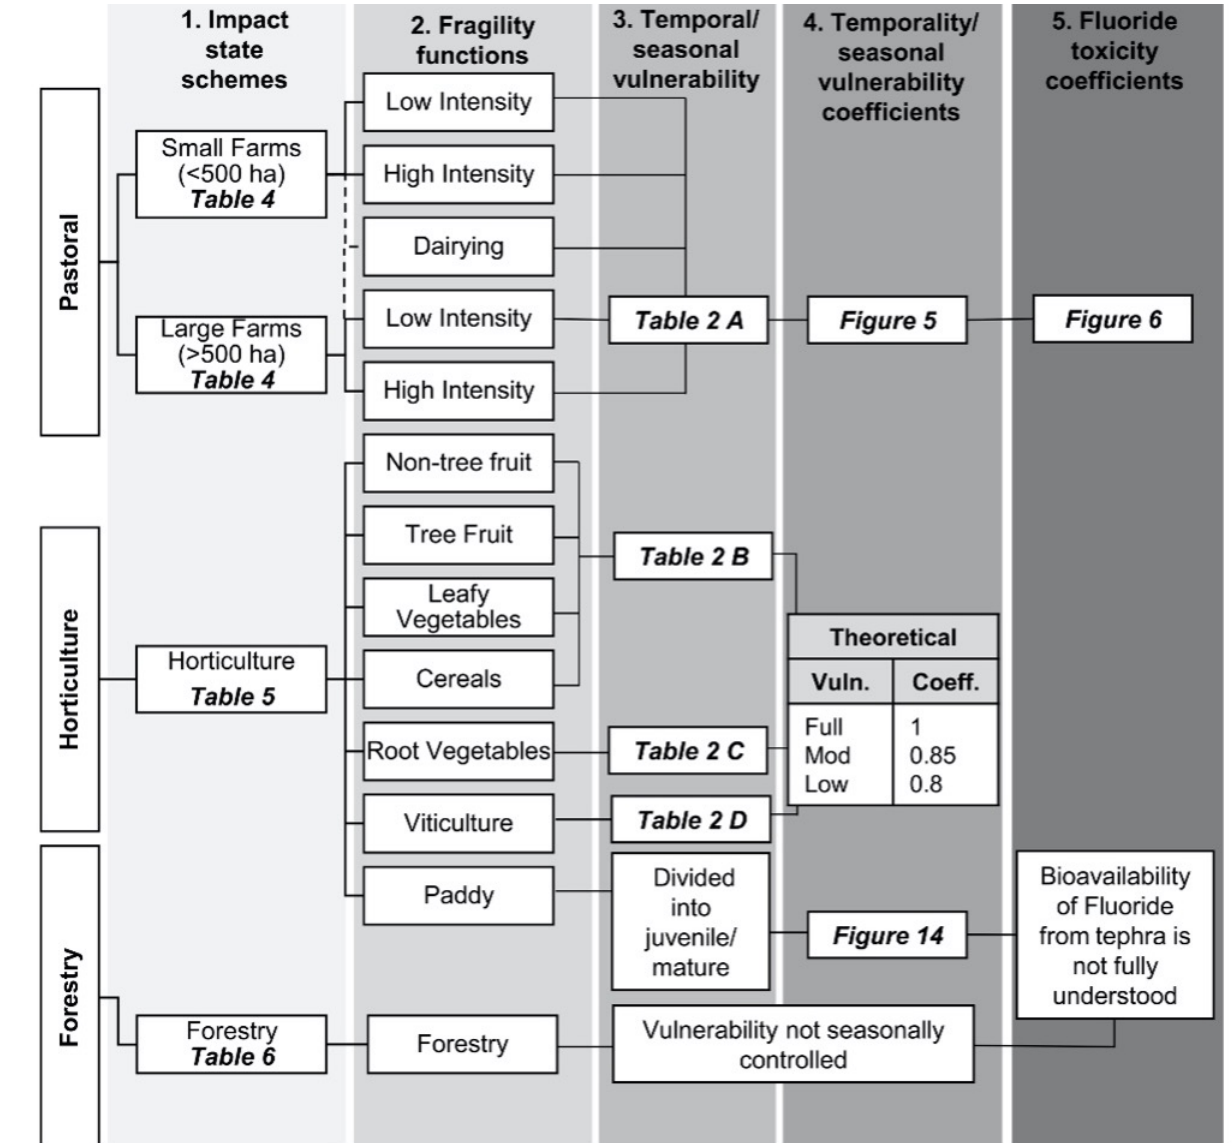
Figure 2: Chart showing the separation of agricultural sectors for damage/production state schemes and fragility functions. Also showing which seasonality and leachable fluoride coefficients will be used for each. Diagram of the datasets created for each agricultural sector for 1) Impact State (IS) schemes (4 sets); 2) Fragility functions (13 functions); 3) Temporality/seasonal vulnerability divisions; 4) Calculated and theoretical temporality/seasonality coefficients; and 5) Fluoride toxicity coefficient for pastoral